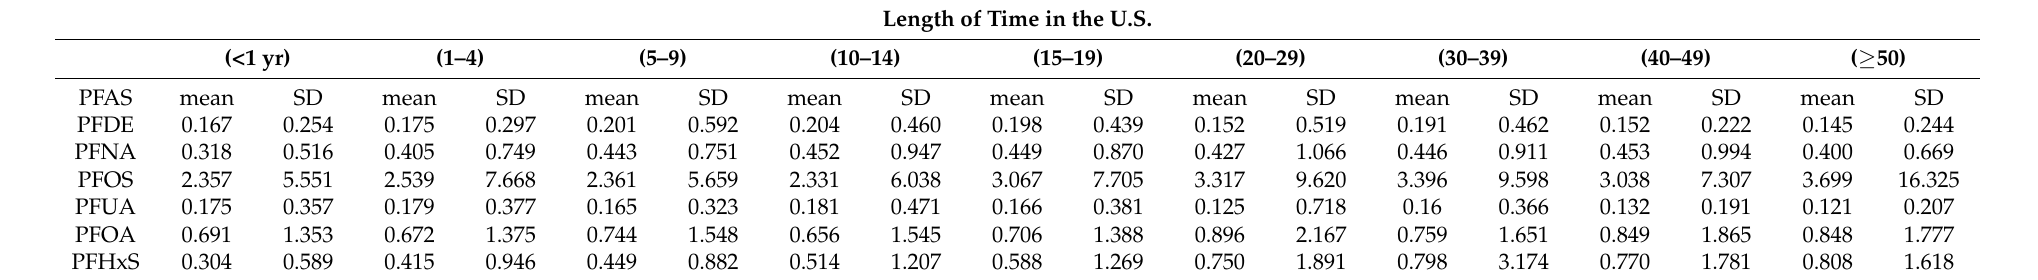
Table 4. PFAS mean (ng/mL) and standard deviation by the length of time in U.S. Length of Time in the